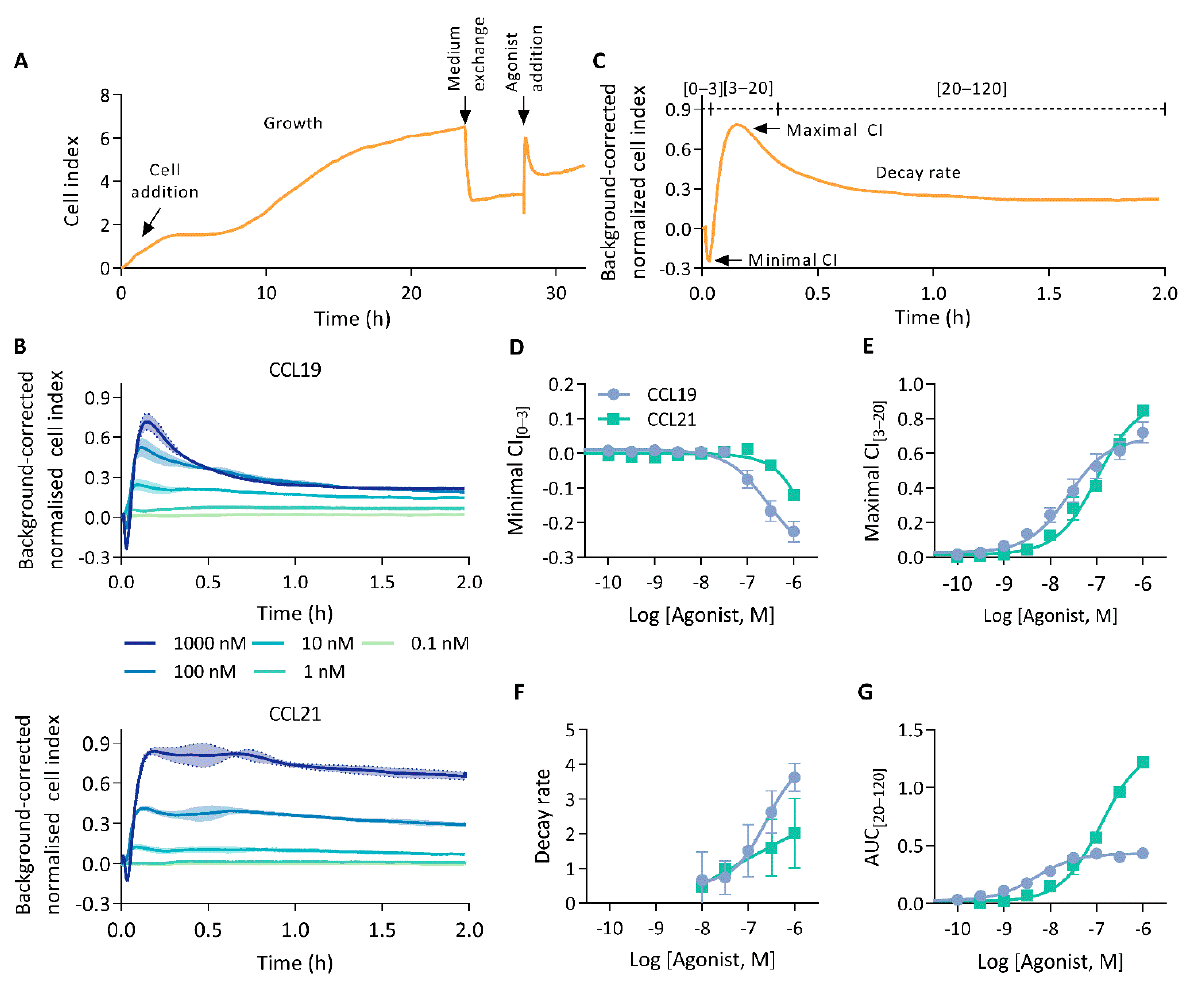
Figure 1. The CCR7 impedance profile. ( A ) Experimental overview of an impedance profile measurement. Cells were seeded and grown for 20 to 24 h. Thereafter, the growth medium was exchanged for serum-free medium and 4 h later cells were stimulated with agonist. ( B ) CEI measurements in HEK293 cells stably expressing CCR7 following stimulation with a CCL19 or CCL21 dilution series. Data are represented as the mean (line) and SD (shaded region) of three independent experiments with two technical replicates each. ( C ) Representation of relevant impedance profile features. The impedance profile is divided into three bins from which the minimal and maximal cell index (CI), and area under the curve (AUC) can be determined. ( D – G ) Dose–response curves of ( D ) minimal CI [0–3] , ( E ) the maximal CI [3–20] , ( F ) the decay rate and ( G ) the AUC of the final bin (AUC [20–120] ). Data are represented as the mean and SD of three independent experiments with two technical replicates each. Curves were fitted to a three-parametric non-linear regression model except for ( F ) which was fit to a four-parametric